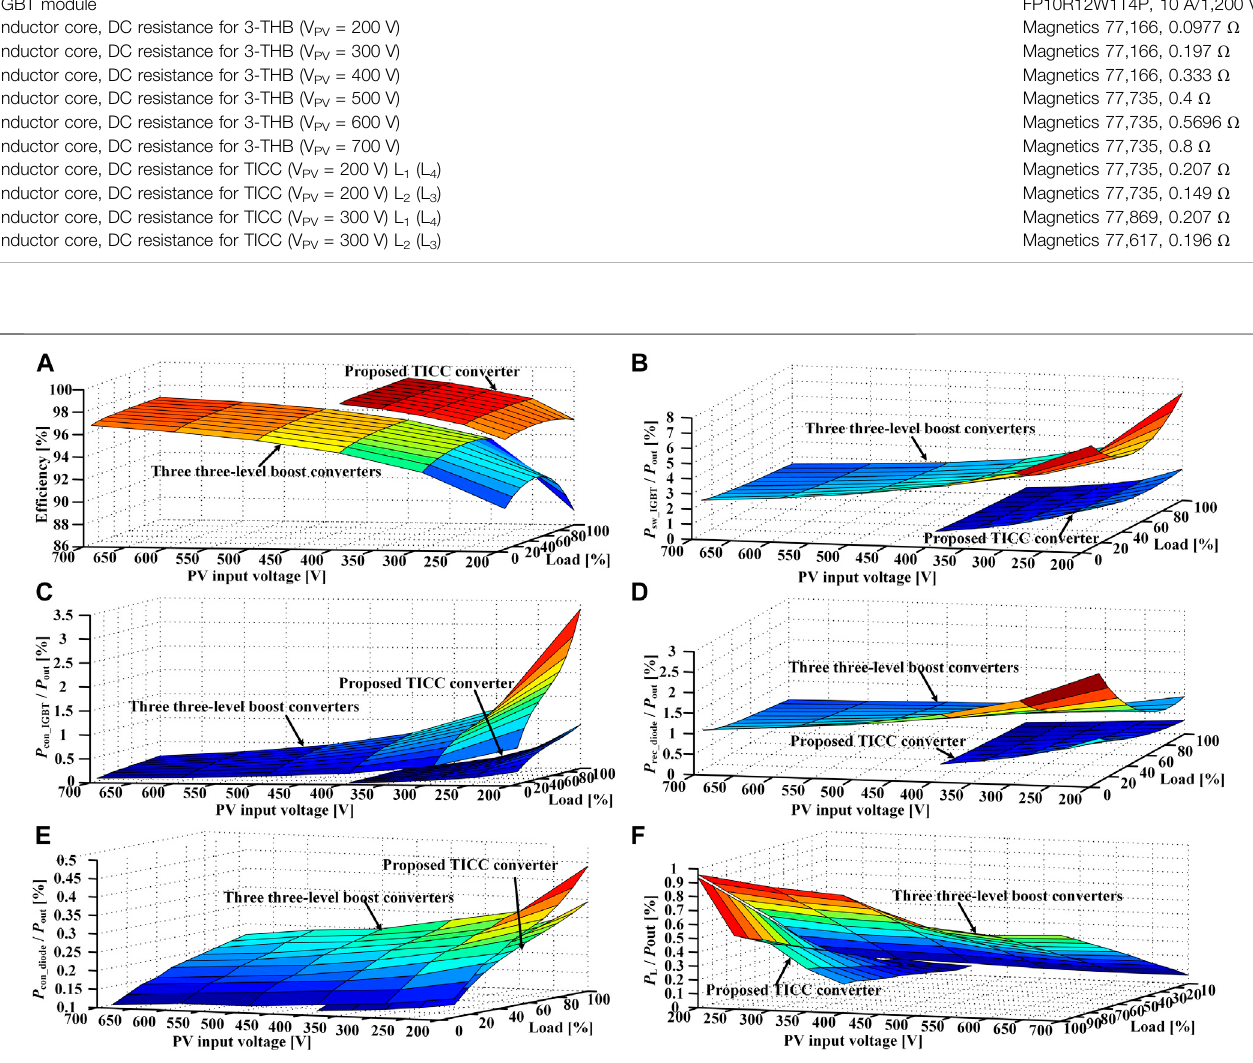
Frontiers in Energy Research |